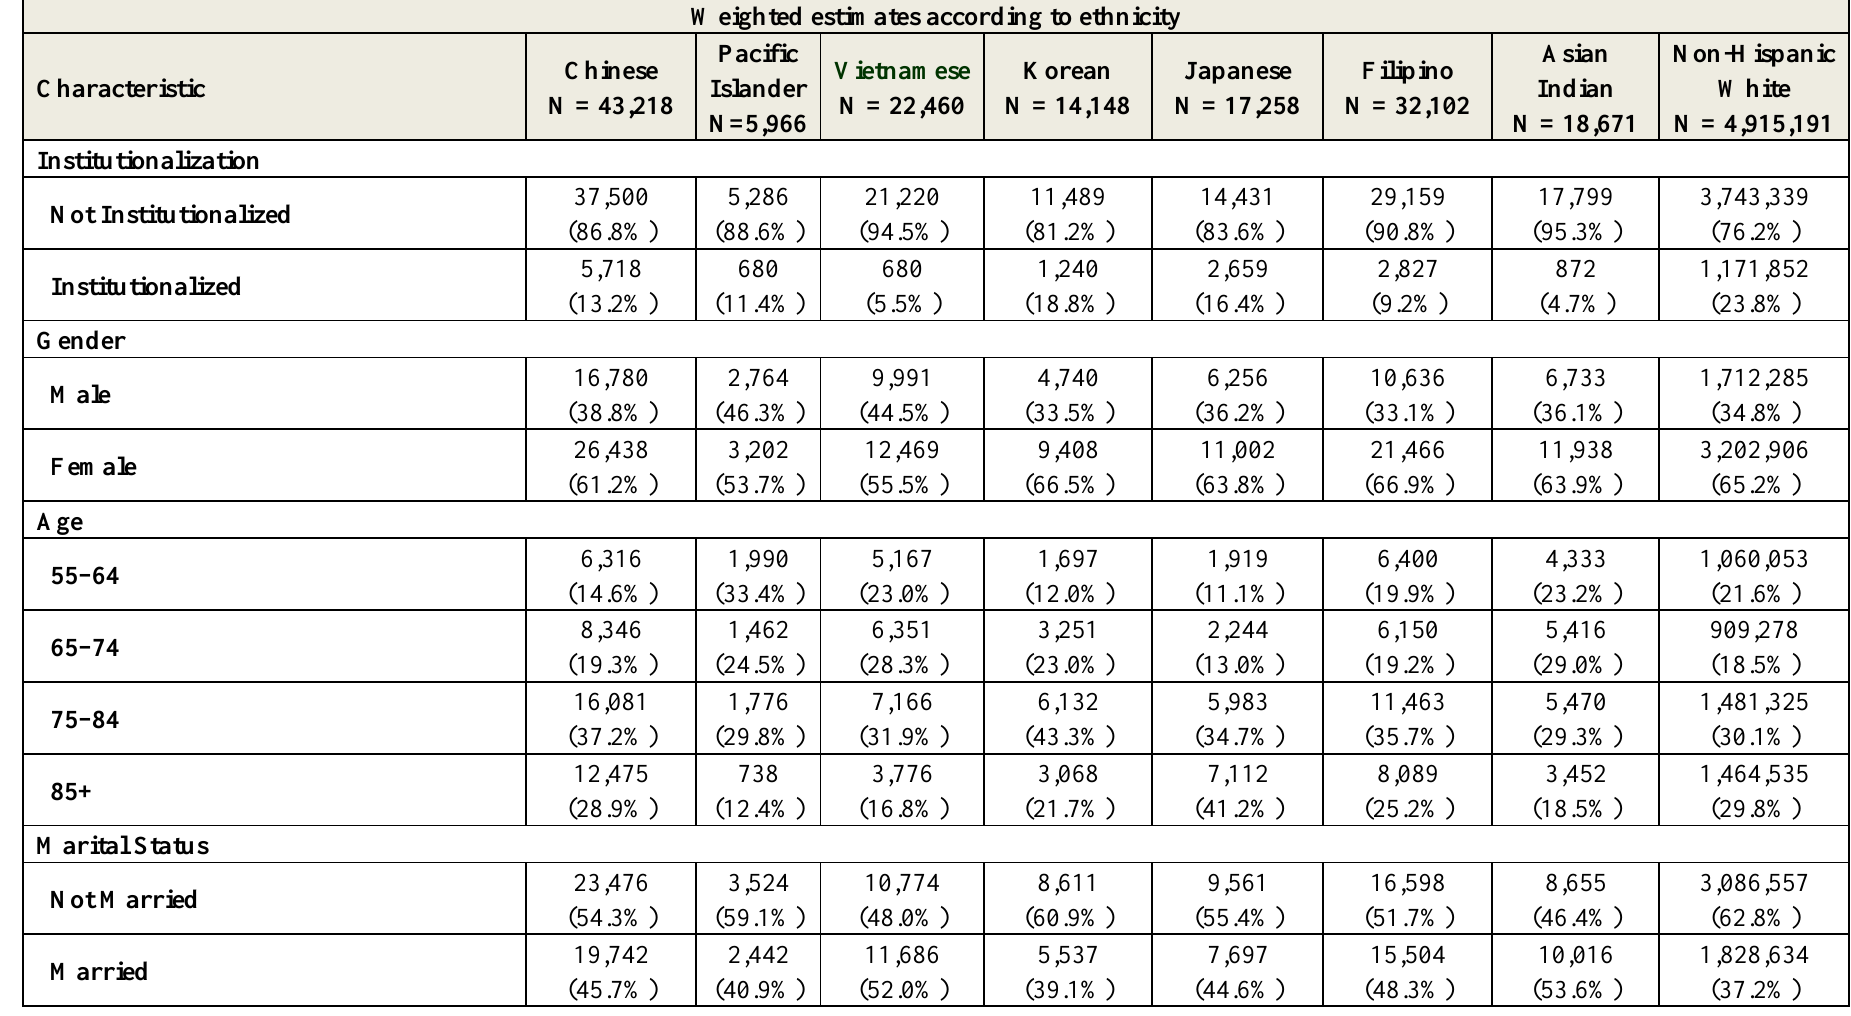
Table 1. Description of Study Participants and Weighted National Estimates Grouped by Ethnicity of Individuals Aged 55 and over with Activities of Daily Living. (Source: 2006 American Community Survey) Weighted estimates according to ethnicity